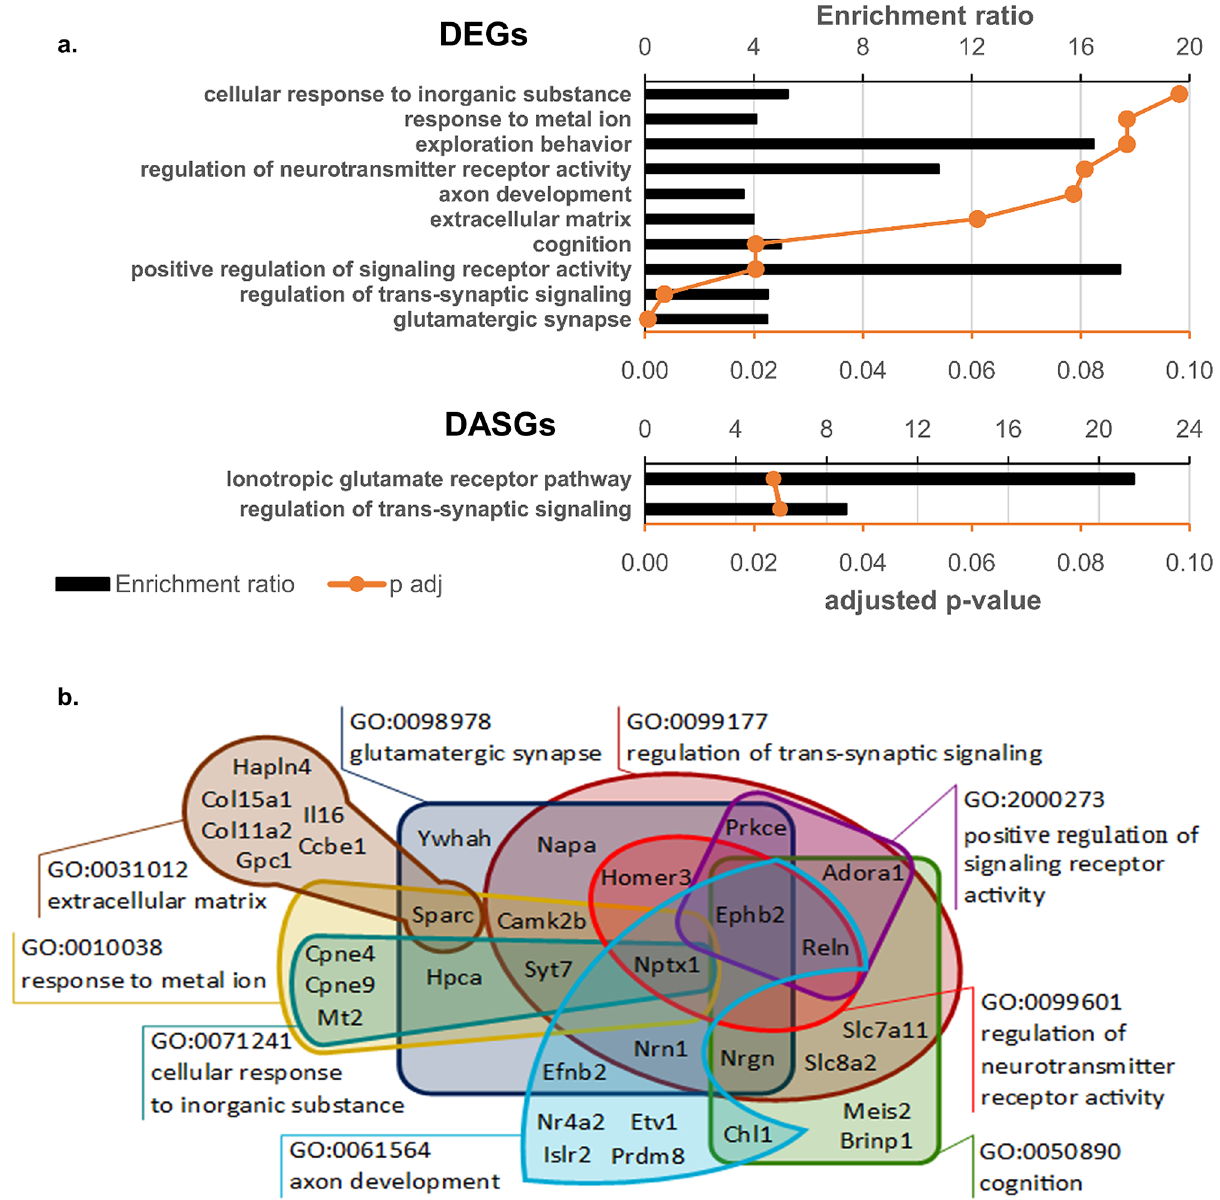
Figure 3. GO enrichment analysis of DEGs and DASGs. ( a ) GO terms overrepresented among DEGs and DASGs, FDR < 0.1. The top X-axis and histogram illustrate the enrichment ratio, whereas the bottom X-axis and orange curve denote significance of the changes. ( b ) A representative diagram illustrating overlaps of the sets of genes matching the enriched GO terms. GO term “exploration behavior” (GO:0035640, associated with genes Brinp1 , Chl1 , and Prkce ) is not shown in the